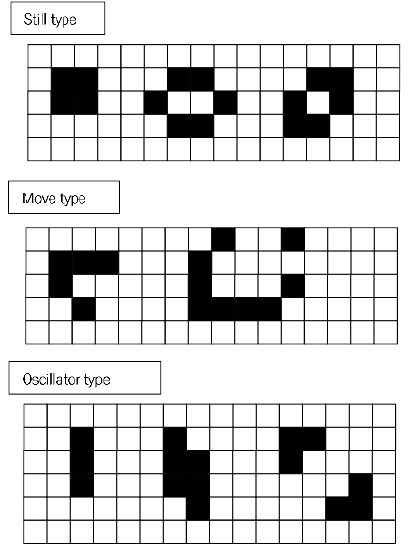
Figure 1. Patterns from Conway’s Game of Life under four rules: (1) a cell with one or no living neighbors dies; (2) a cell with four or more living neighbors dies; (3) a cell with three living neighbors is born; and (4) a cell with two or three living neighbors survives. The typical patterns that emerge can be categorized into three groups: still, moving, or oscillation.